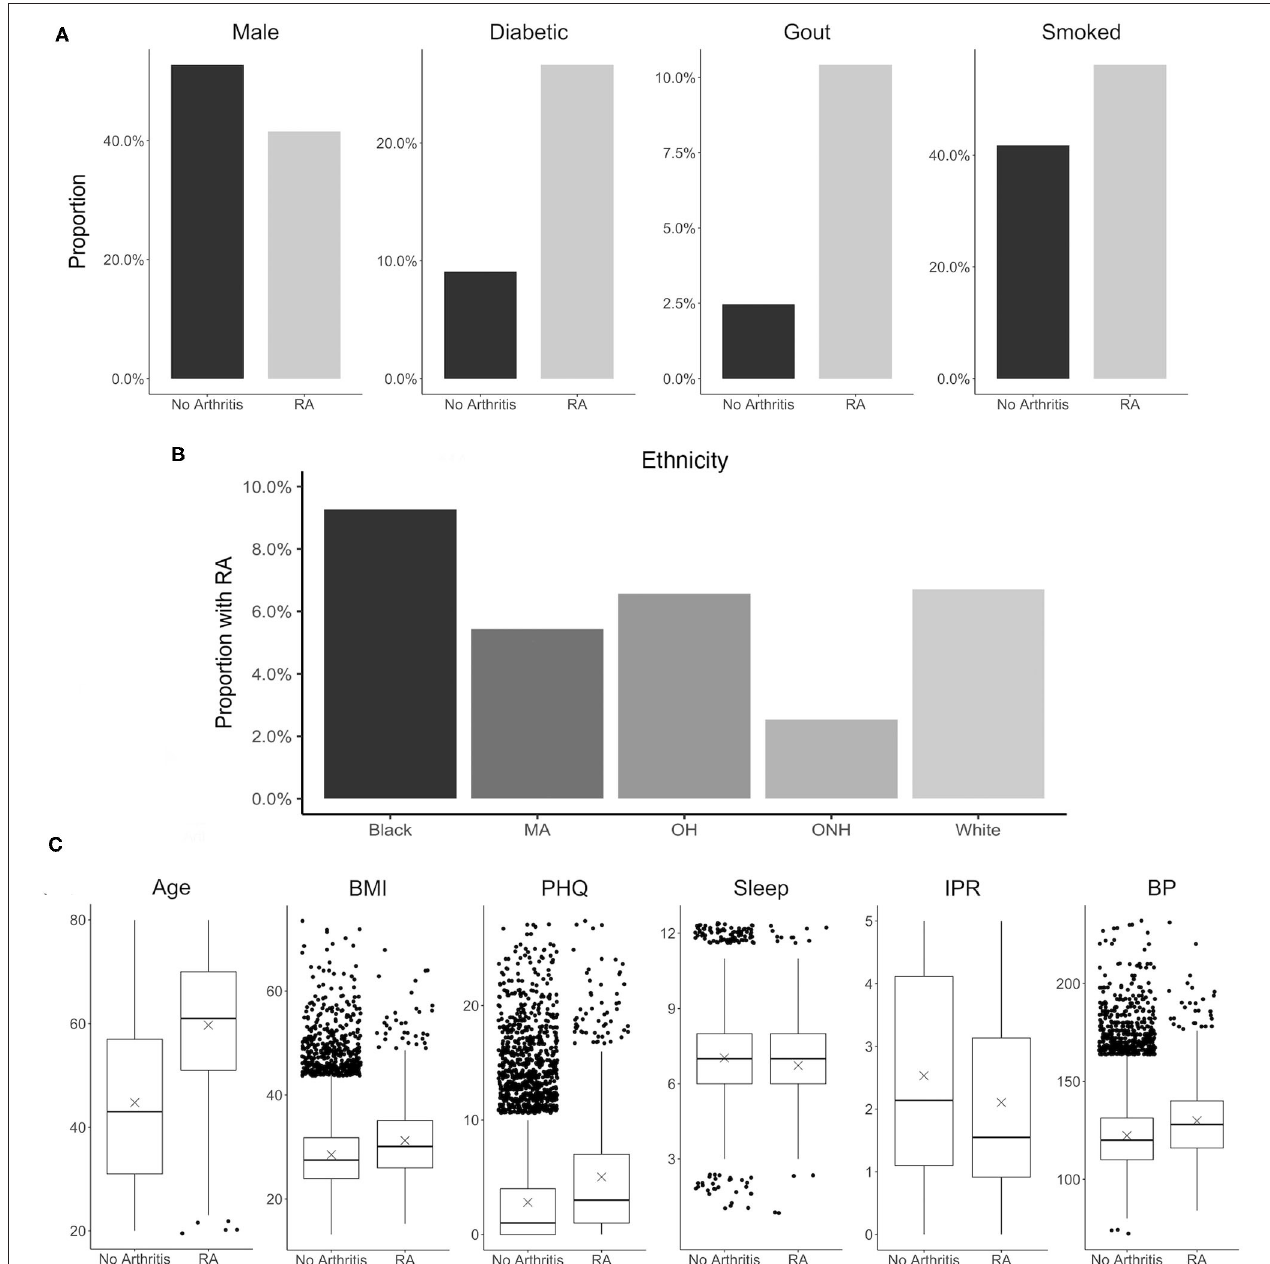
FIGURE 3 | Distribution of various RA risk factors in the study population. (A) Comparison between RA and no arthritis population for risk factors coded as binary variables. (B) Prevalence of RA among various ethnicity. (C) Comparison between RA and no arthritis population for risk factors coded as continuous variables. Units: Age, years; BMI, kg/m 2 ; PHQ, PHQ score; Sleep, hours; IPR, nondimensional; Systolic, mmHg. MA, Mexican-American; OH, Other Hispanic.